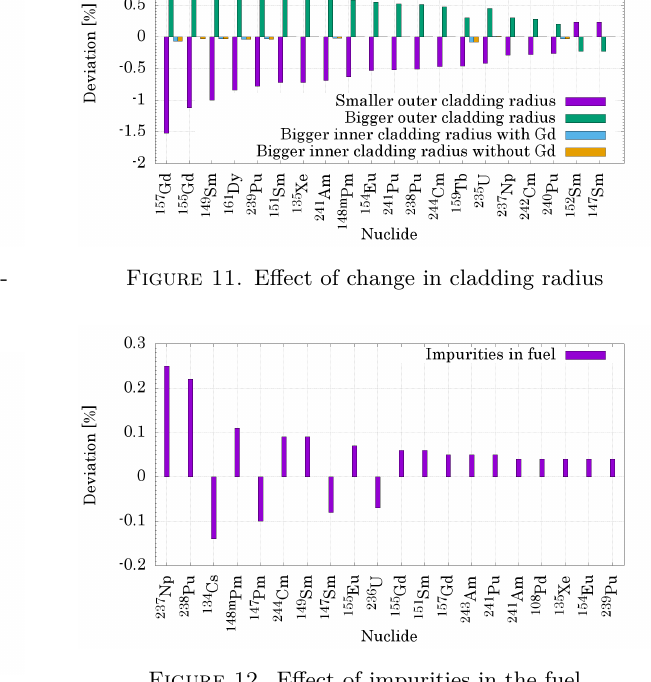
Figure 10. Effect of change in fuel radius